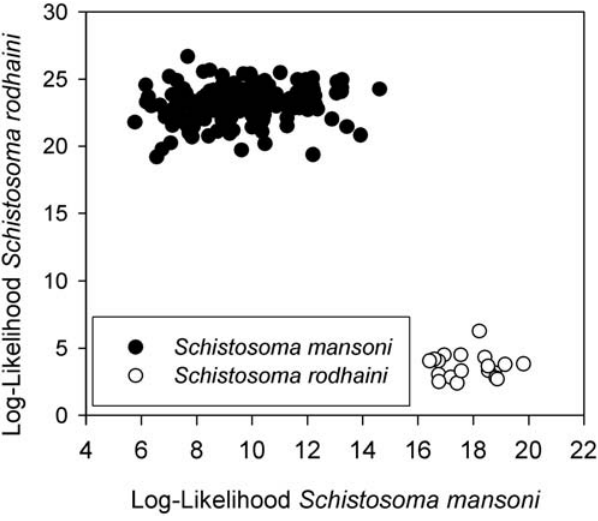
Figure 2. Population assignment graph of S.mansoni and S. rodhaini based on 7 microsatellite markers. The dot plot indicates the log-likelihood (absolute value) that each individual belongs to either species. The lower the log likelihood value, the more likely the individual belongs to that species.